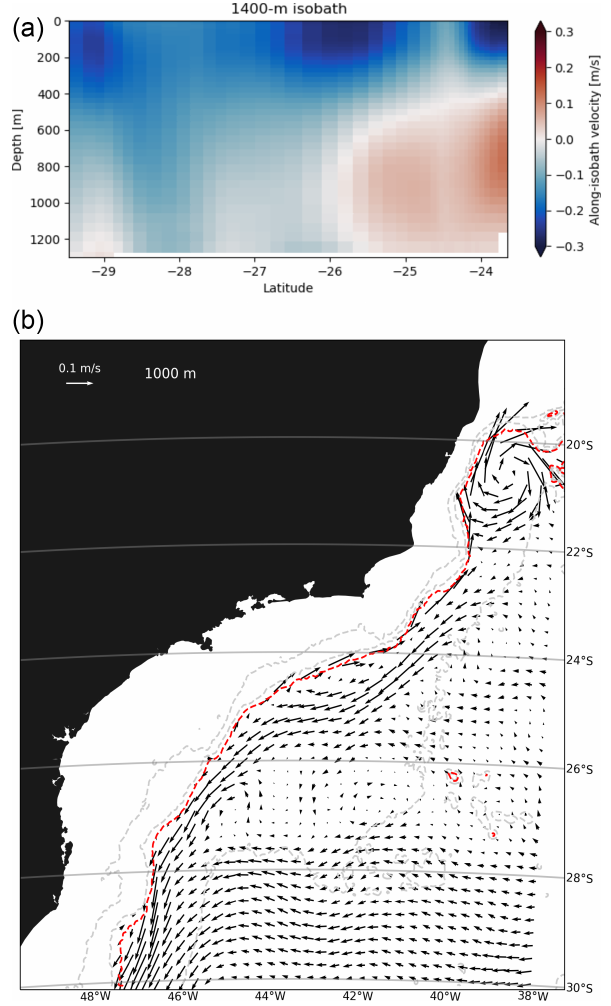
Figure 5. Graphical outputs of the LLC2160 focused on the San- tos Bifurcation. (a) The bifurcation is identified as the white zone located around 26 ◦ S between the 800 and the 1200m isobath. (b) The bifurcation is recognized as the zone of velocities tending to 0cms − 1 at 26 ◦ S–44 ◦